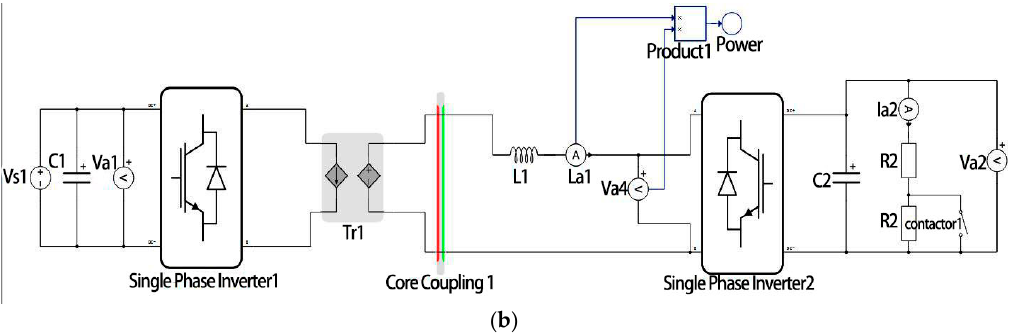
Figure 11. ( a ) The hardware block diagram of the Typhoon HIL system; ( b ) Typhoon based converter virtual hardware circuit in software platform.